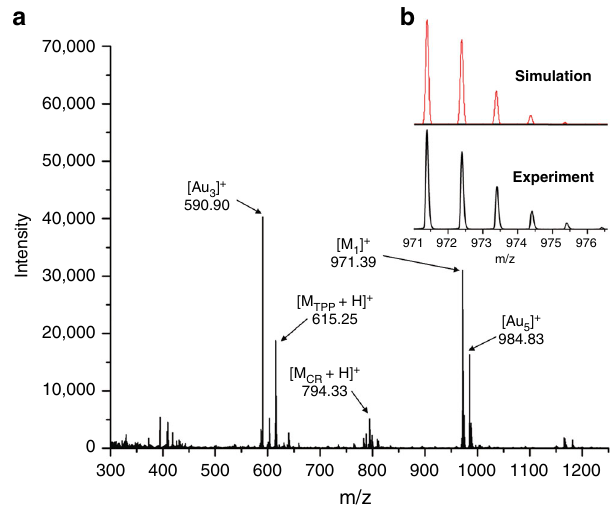
Fig. 3 ToF-SIMS analysis of 1 on Au(111). a ToF-SIMS spectrum showing the molecular weight of positive ions (coverage of Br-TPP : ~0.5 ML). M 1 : molecular weight of divergent cross-coupling product 1 ; M CR : molecular weight of cross-coupling product of one Br-TPP with one ICBP ; M TPP : molecular weight of debrominated product of Br-TPP . b Experimental and simulated isotopic distribution of [M 1 ] + ions of